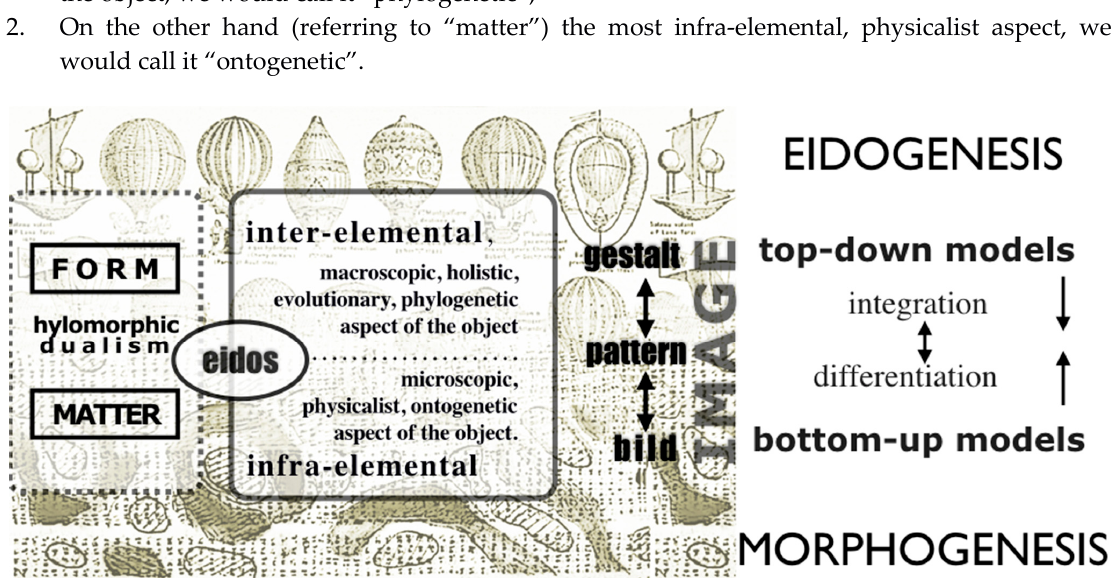
Figure 2. Alternative scheme of the hylomorphic argument—cfr.